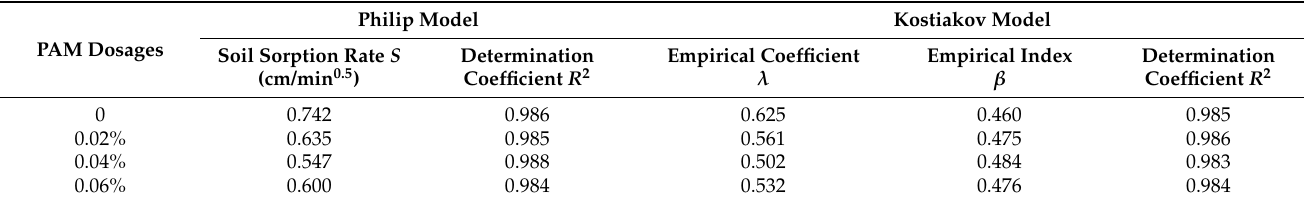
Table 2. Infiltration model parameters under different PAM application dosages.